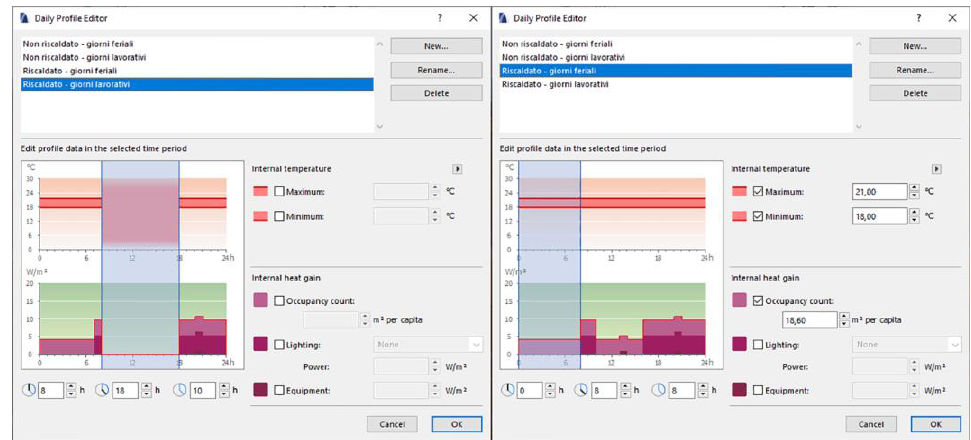
Figure 11. Schedules of the operation profiles. Note how the occupation of the houses changes between working and school days ( left ) and non-working days ( right ) within the period of the year in which the heating is activated.